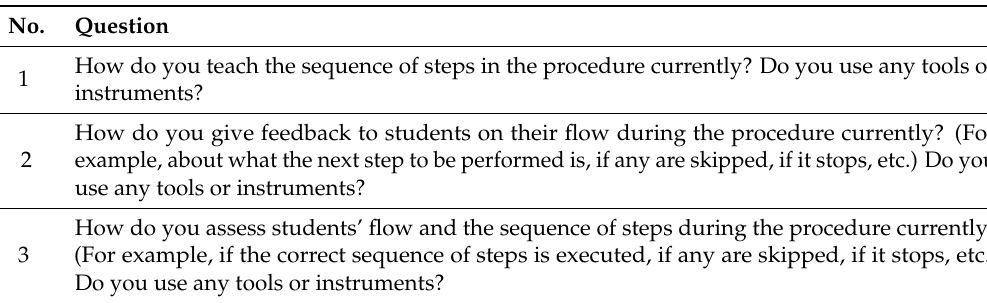
Table 2. Current teaching of the sequence of